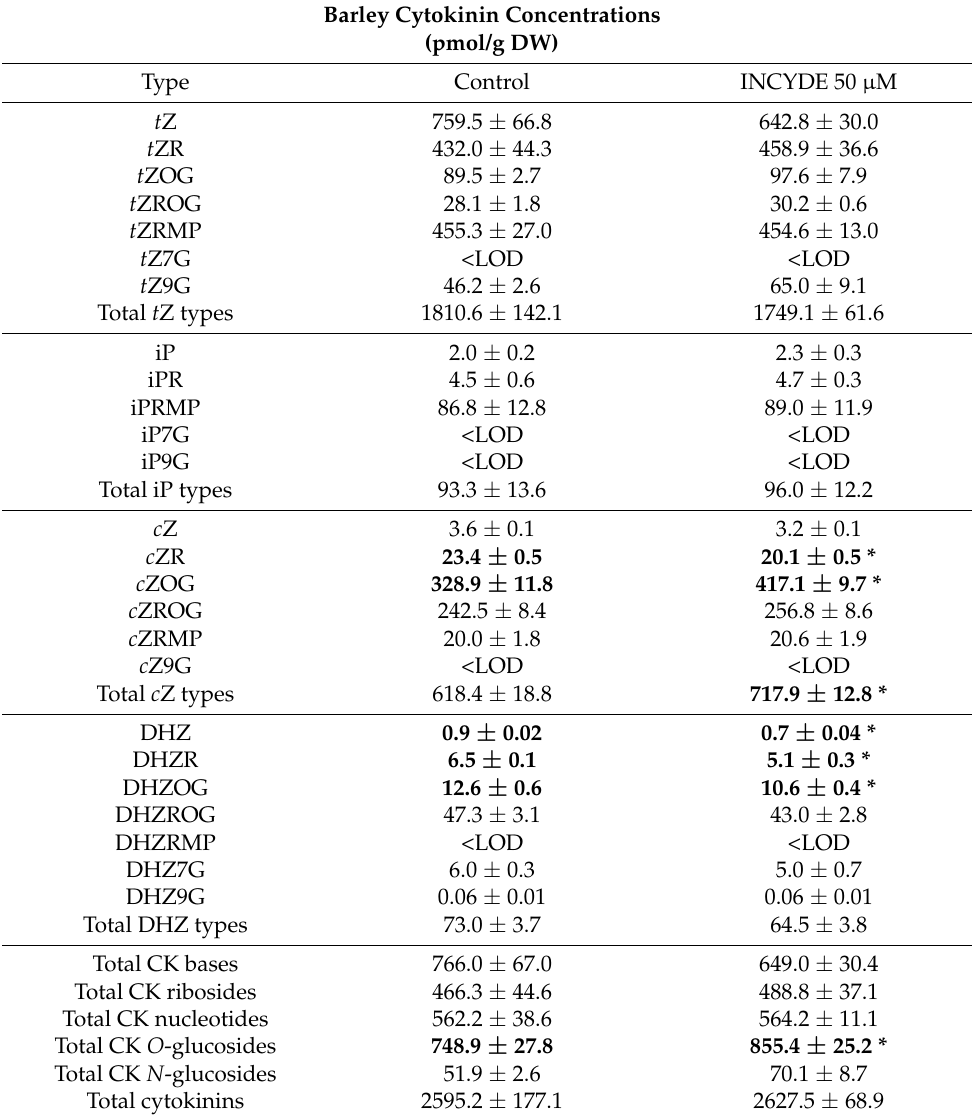
Table 3. LC–MS/MS analyses of the quantity of cytokinins in barley (cultivar Quench, 2014/15) grains treated at anthesis with INCYDE. Measurements were made at four days after